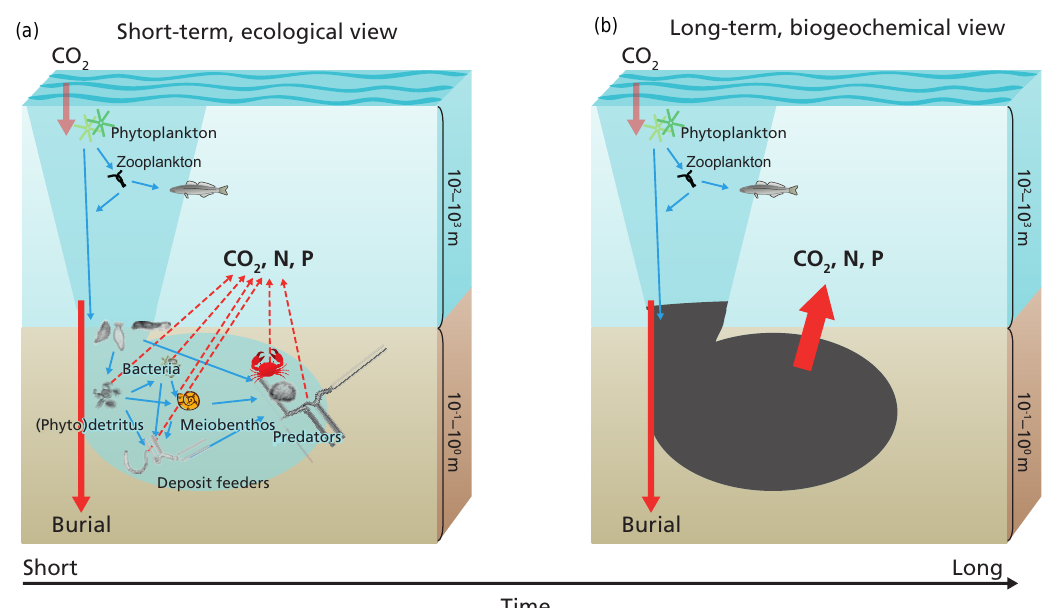
Figure 3. Carbon processing in marine sediments in the short-term (a) and the long-term (b) . Organic matter produced in the sunlit layer of the ocean and delivered to the sediments is either consumed by organisms or buried. The organic matter consumed by organisms is used to synthesize biomass or is metabolized to carbon dioxide and nutrients. In the long-term or at steady-state, i.e., the biomass of benthic organisms does not change, the benthic community can be considered a black box diverting organic matter into either metabolites or the geosphere